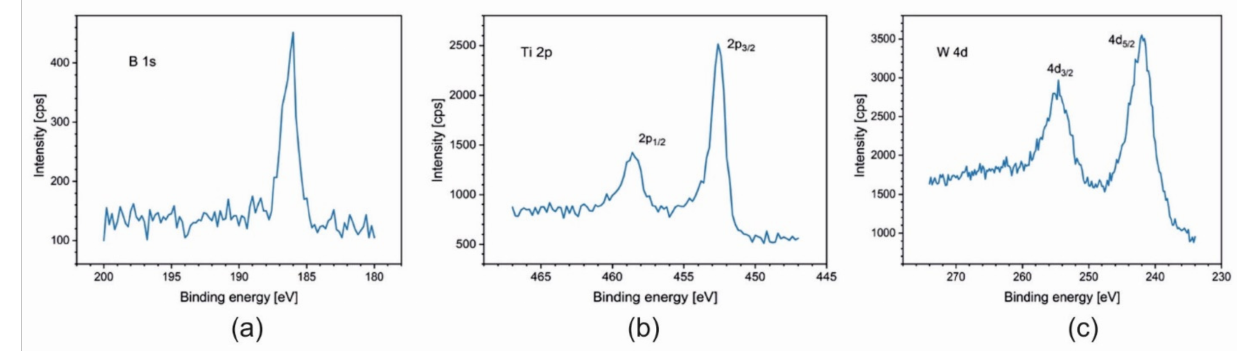
Figure 7. XPS spectra of ( a ) B 1s; ( b ) Ti 2p; and ( c ) W 4d obtained after 120 min of sputtering for the coating Ti 0.58 W 0.42 B 2 .